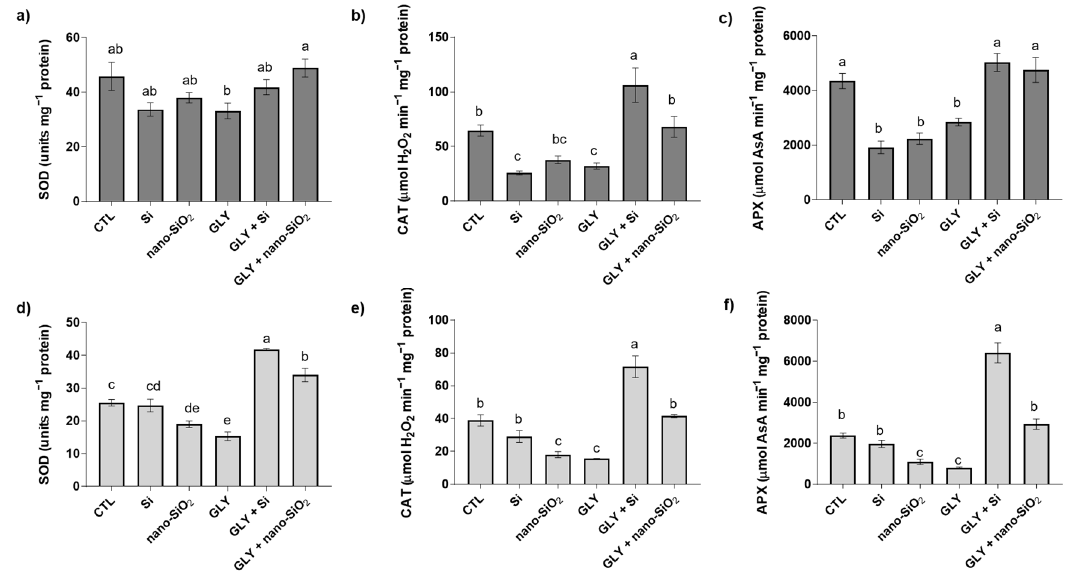
Figure 6. Total activity of superoxide dismutase (SOD; a , d ) and catalase (CAT; b , e ) and ascorbate peroxidase (APX; c , f ) of S. lycopersicum plants after 4 weeks of growth. Dark and light bars represent shoots and roots, respectively. Data presented are mean ± STDEV ( n ≥ 3). Different letters (a–e) above bars indicate significant statistical differences between treatments (Tukey: p ≤ 0.05).